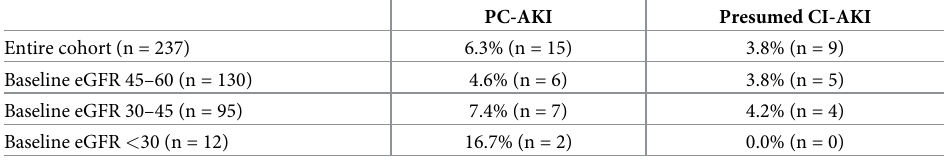
PC-AKI Presumed CI-AKI